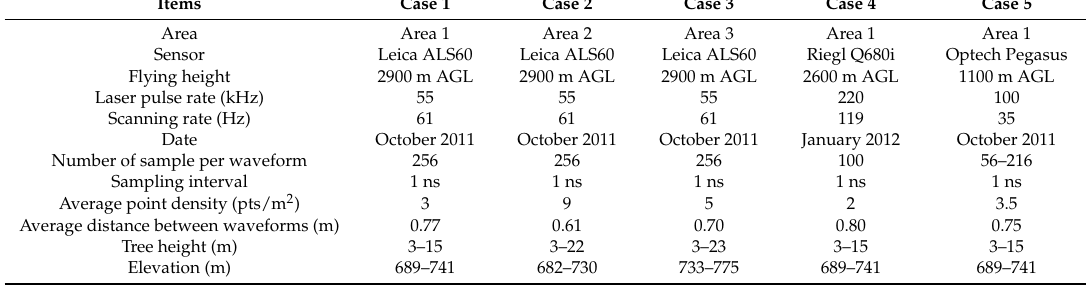
Table 1. The summary of the test data.